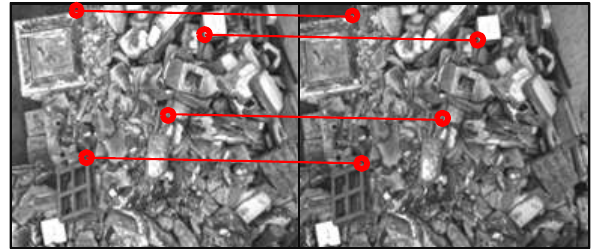
Figure 2. Feature Point Extraction between Image Data from Left Side and Right Side of the Stereo-vision Camera